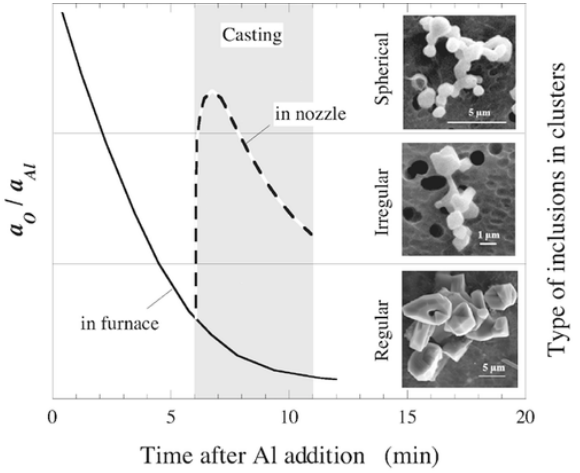
Figure 6. Illustration and SEM micrographs of possible transformation of inclusion morphology in clusters in the melt in the furnace and nozzle during casting as a function of holding time after the addition of Al [19]. © 2015 WILEY-VCH Verlag GmbH & Co. KGaA, Weinheim. Zhang et al. [18] extracted and compared MnS inclusions in continuous bloom and rolled heavy rail steels (0.77 wt.% C, 0.63 wt.% Si, 0.87 wt.% Mn, 0.028 wt.% Cr), as seen